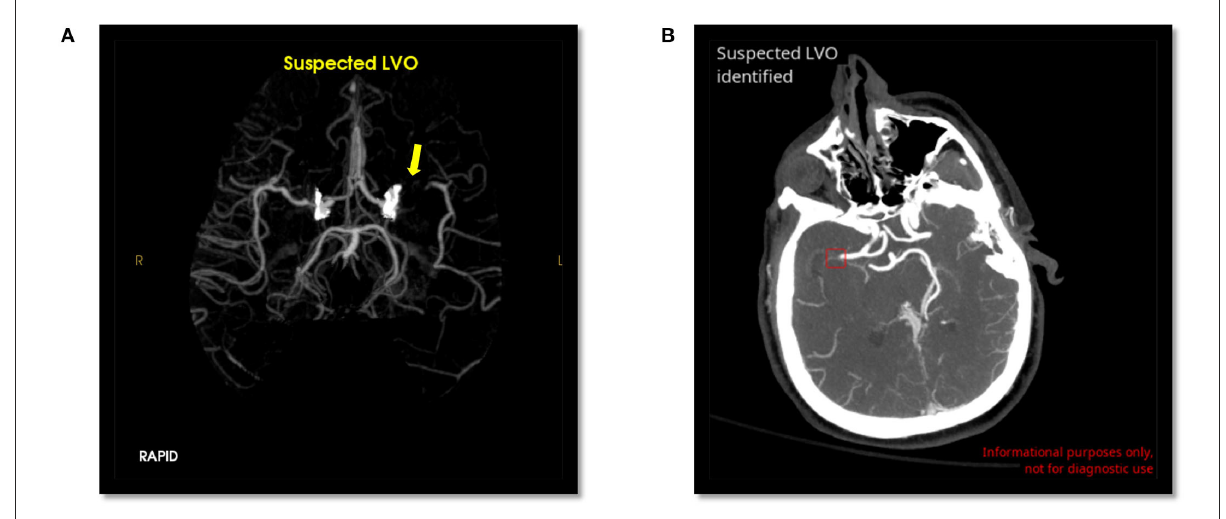
FIGURE1 Positive LVO detected by RAPID LVO ( A , yellow arrow, left M1 MCA) and CINA LVO ( B , red box, right M1